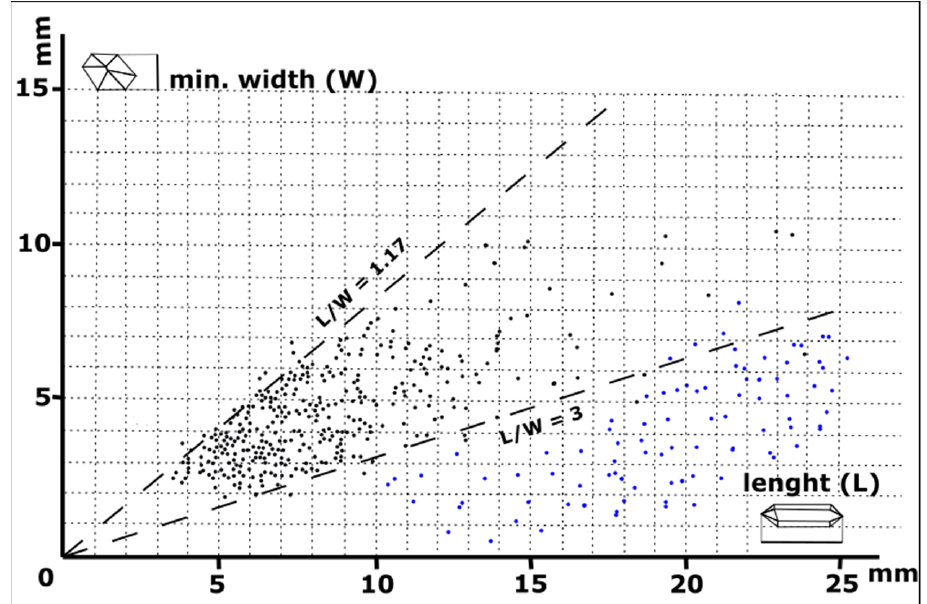
Figure 8. Diagram of length vs. minimal width on 355 crystals from the Burano Formation (black spots) and 104 hyaline quartz crystals from Alps (blue spots).